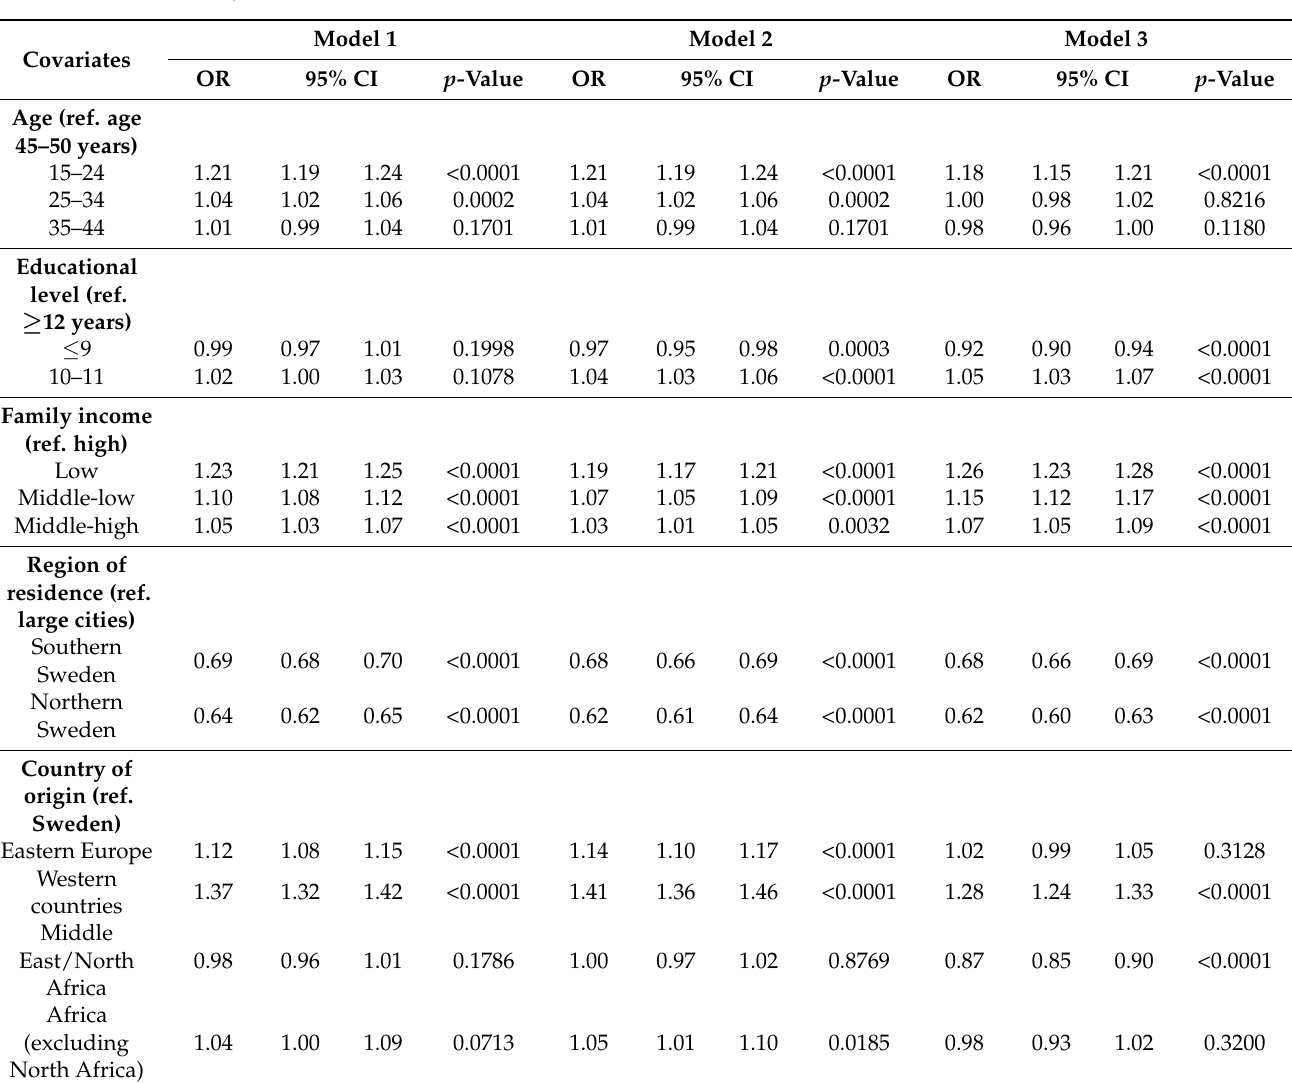
Table 2. The association of individual sociodemographic factors, cervical cancer and parity with antibiotic treatment (192,065 cases) for